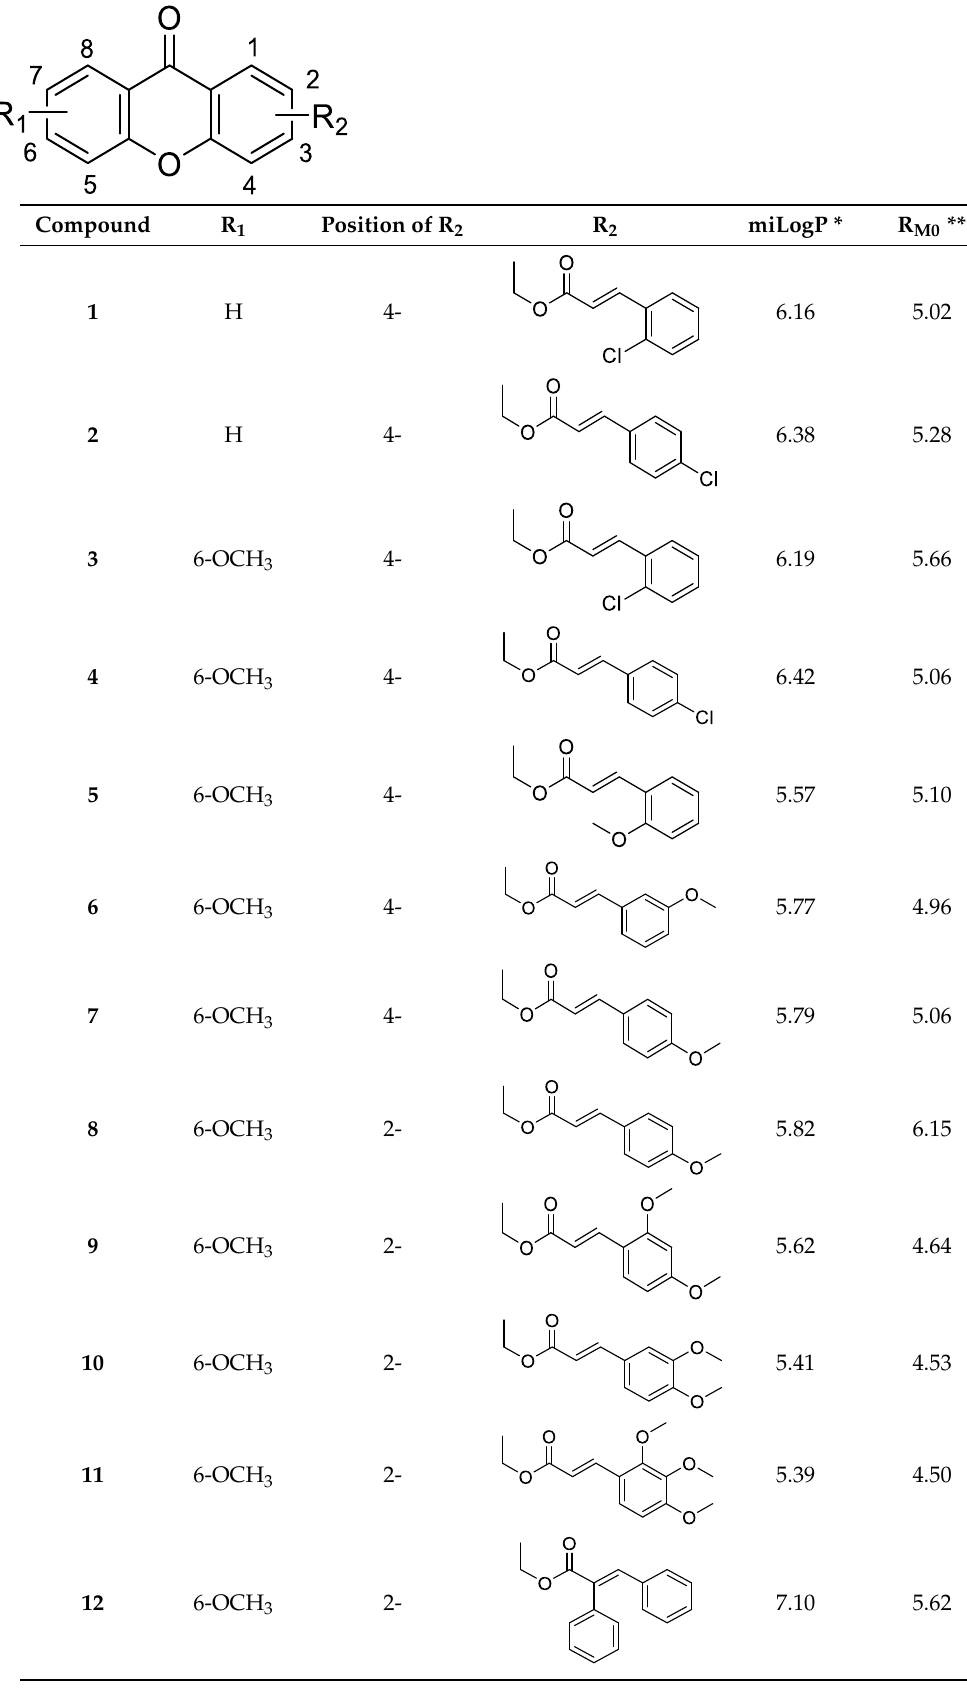
Table 1. Chemical structures and lipophilicity parameters of tested compounds.